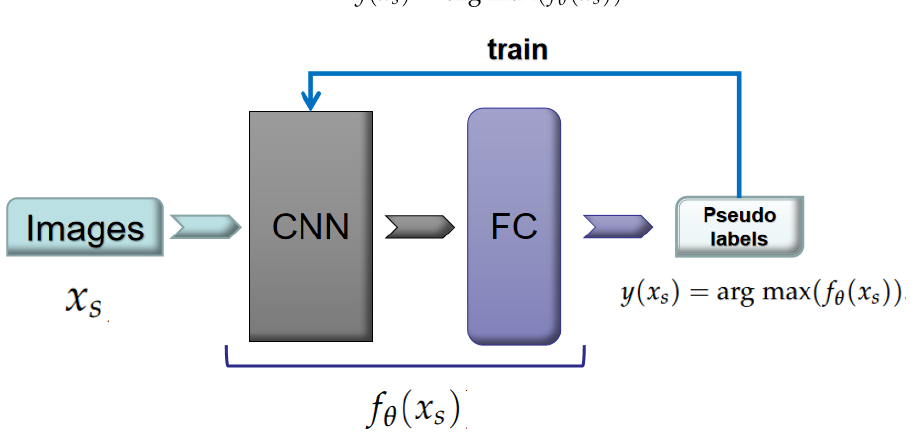
Figure 2. Using the predictions of the network as pseudo labels that could be used to train the